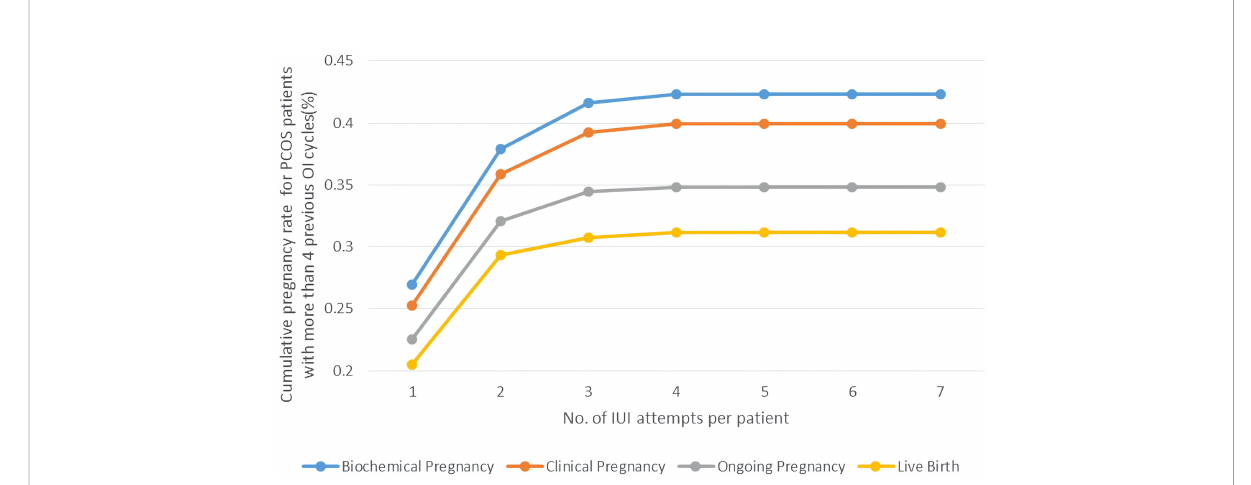
FIGURE 4 Cumulative pregnancy rate of PCOS women with >3 previous OI cycles undergoing different attempts of IUI in line charts. Pregnancy outcomes were as follows: biochemical pregnancy, clinical pregnancy, ongoing pregnancy, and live